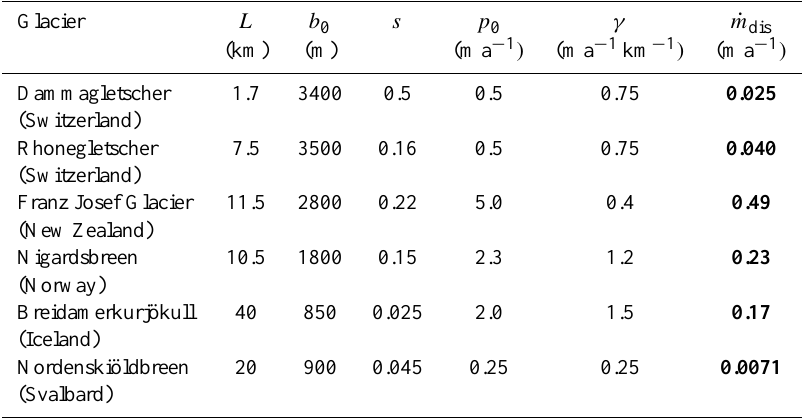
Table 1. Characteristic values of geometry and precipitation regime for some glaciers, and the calculated mean dissipative melt rate (last column). Data estimated from Swisstopo (Dammagletscher and Rhonegletscher), Anderson et al. (2006) (Franz Josef Glacier), Andreassen and Windsvold (2012) (Nigardsbreen), Björnsson et al. (2003) (Breidamerkurjökull), Van Pelt et al. (2012) (Nordenskiöldbreen). Glacier L b 0 s p 0 γ ˙ m dis (km) (m) (ma − 1 ) (ma − 1 km − 1 ) (ma − 1 ) Dammagletscher 1.7 3400 0.5 0.5 0.75 0.025 (Switzerland) Rhonegletscher 7.5 3500 0.16 0.5 0.75 0.040 (Switzerland) Franz Josef Glacier 11.5 2800 0.22 5.0 0.4 0.49 (New Zealand) Nigardsbreen 10.5 1800 0.15 2.3 1.2 0.23 (Norway) Breidamerkurjökull 40 850 0.025 0.17 (Iceland) Nordenskiöldbreen 20 900 0.045 0.25 0.25